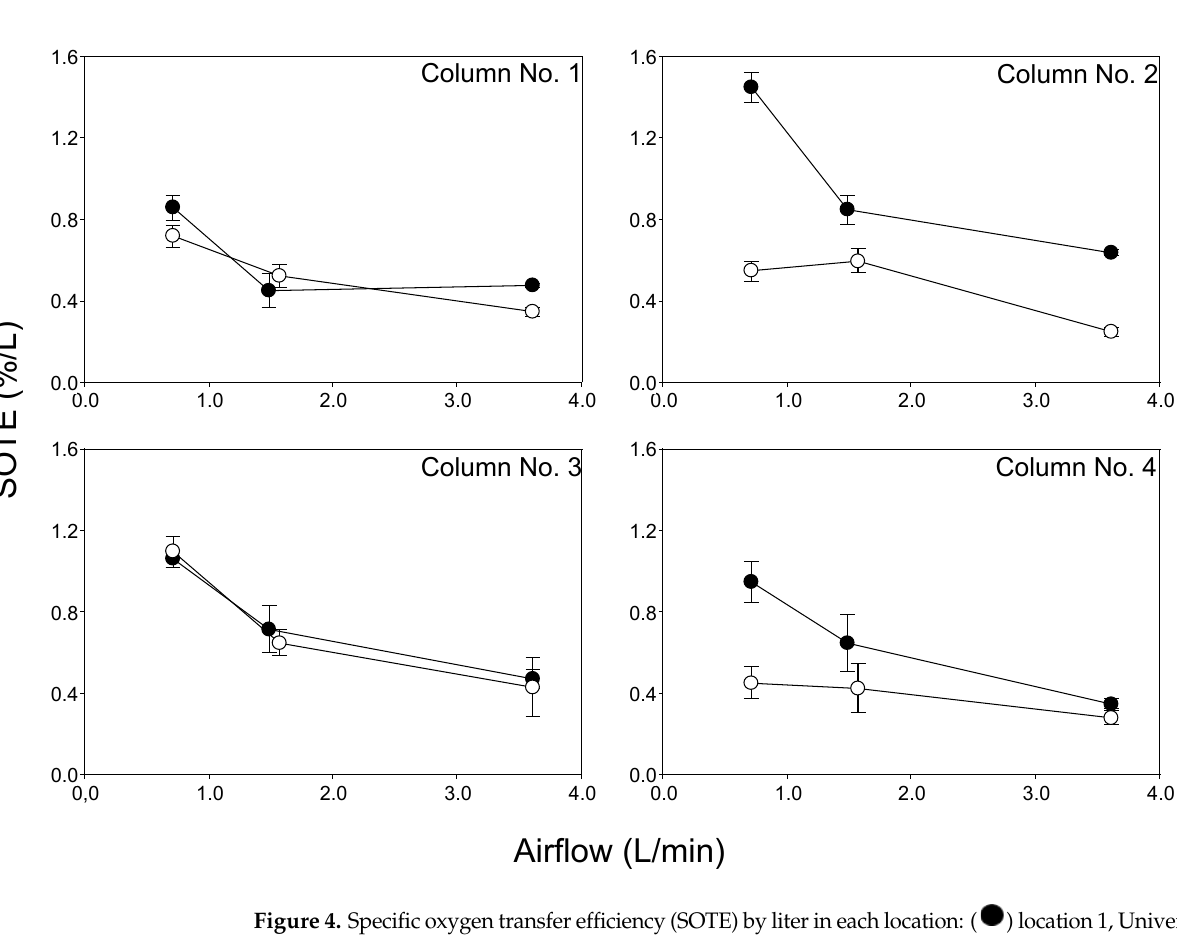
Figure 3. Specific oxygen transfer rate (SOTR) by liter in each location: ( ) location 1, Universidad Católica de Maule (Talca, Chile); ( ) location 2, Universidad Militar Nueva Granada (Cajicá, Co- lombia).